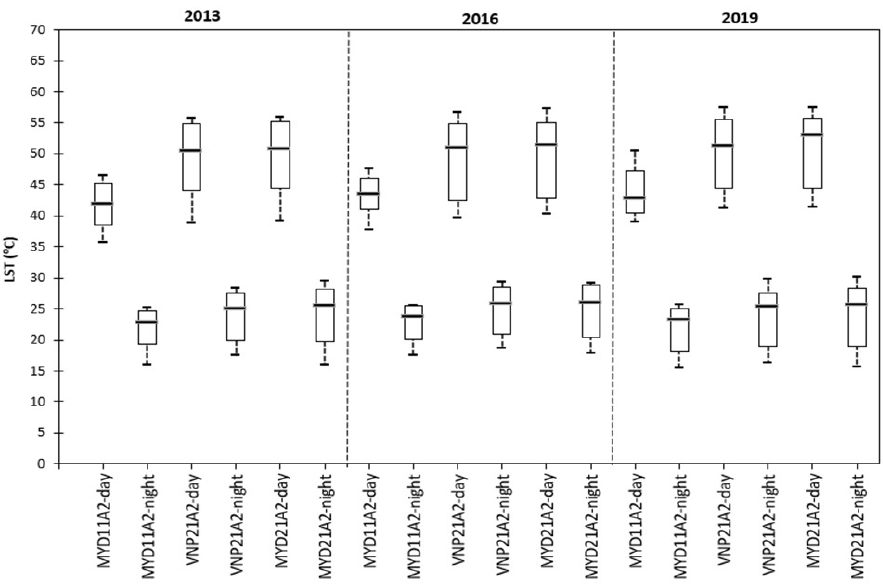
Figure 11. Boxplot showing the yearly diurnal ranges for the three LST products for Kimberley. This consists of 25th percentile (1st quartile), median (2nd quartile), 75th percentile (3rd quartile), and min (10th percentile)/max (90th percentile)